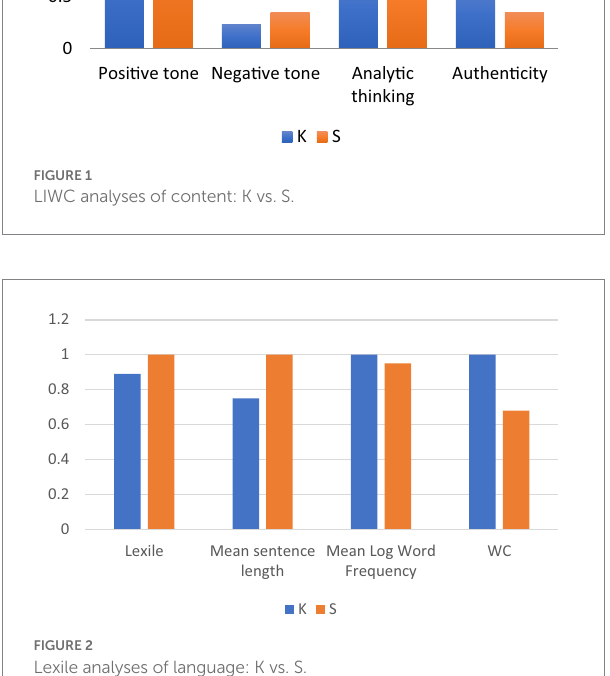
FIGURE 2 Lexile analyses of language: K vs.